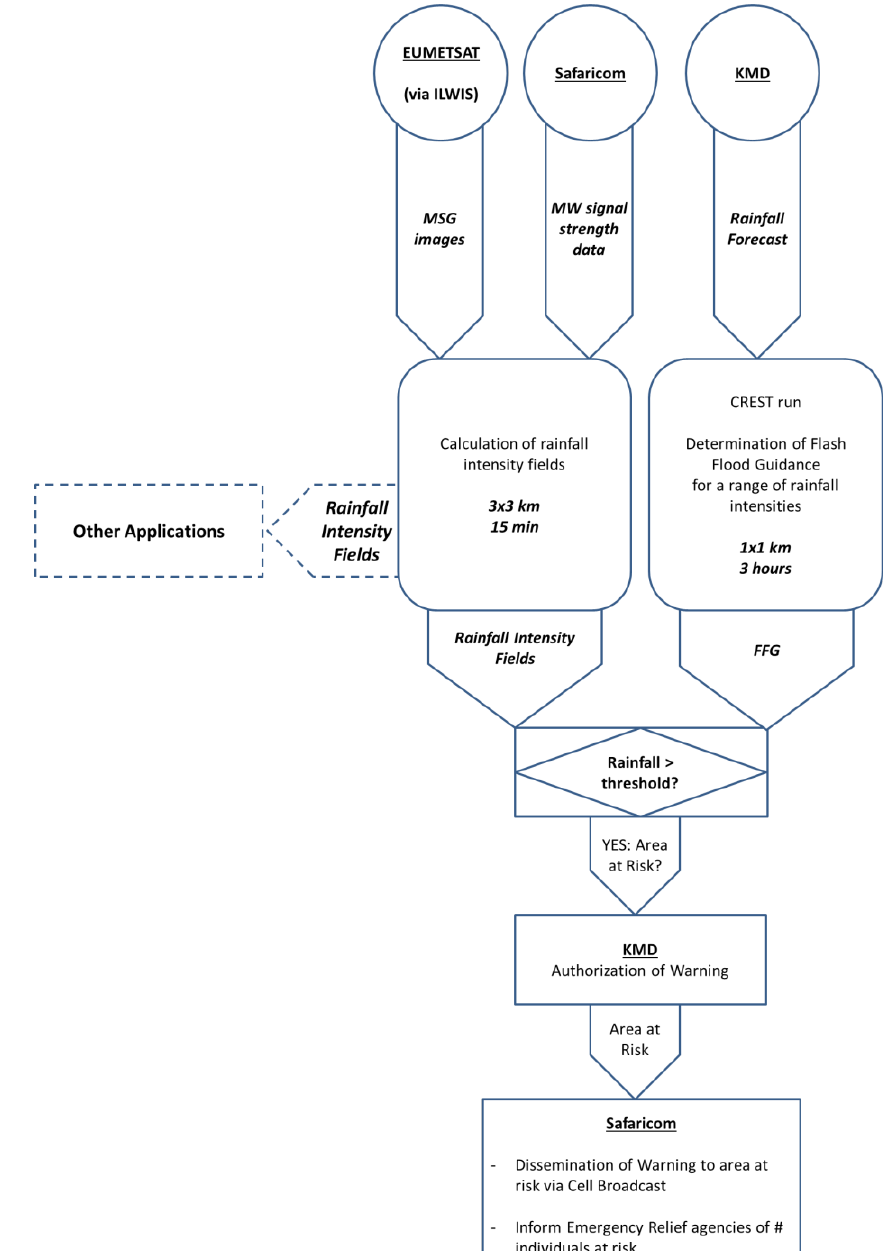
Figure 3. Flow diagram showing the flows of information that make up the flash flood early warning system. KMD, Kenya Meteorological Department; FFG, Flash Flood Guidance; CREST, Coupled Routing and Excess